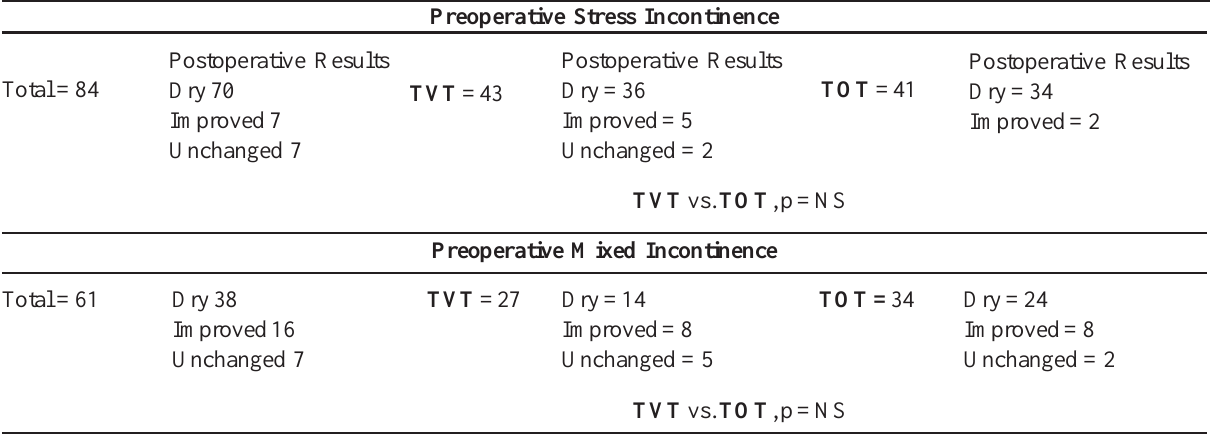
Table 5 – Outcome of patients with mixed incontinence.